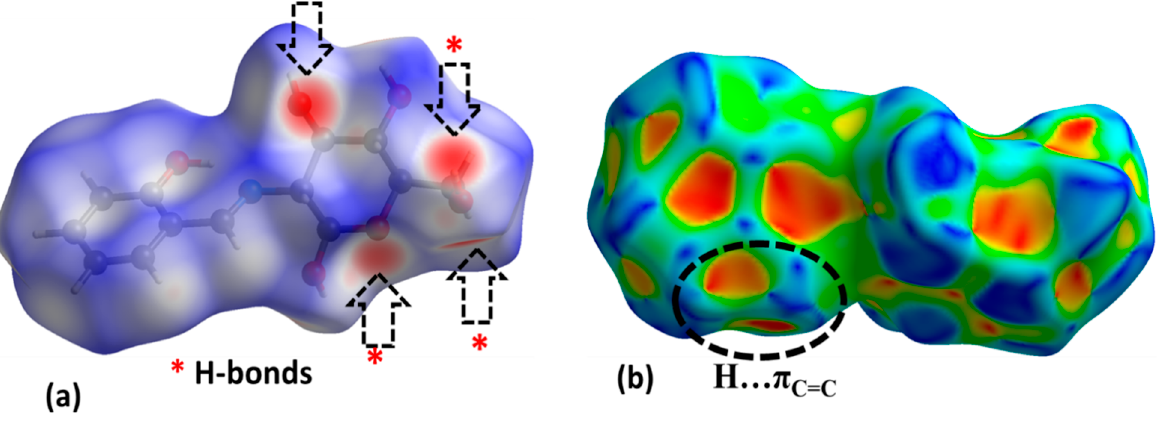
Figure 4. ( a ) d norm , ( b ) shape index, and ( c ) the FP network virtual.